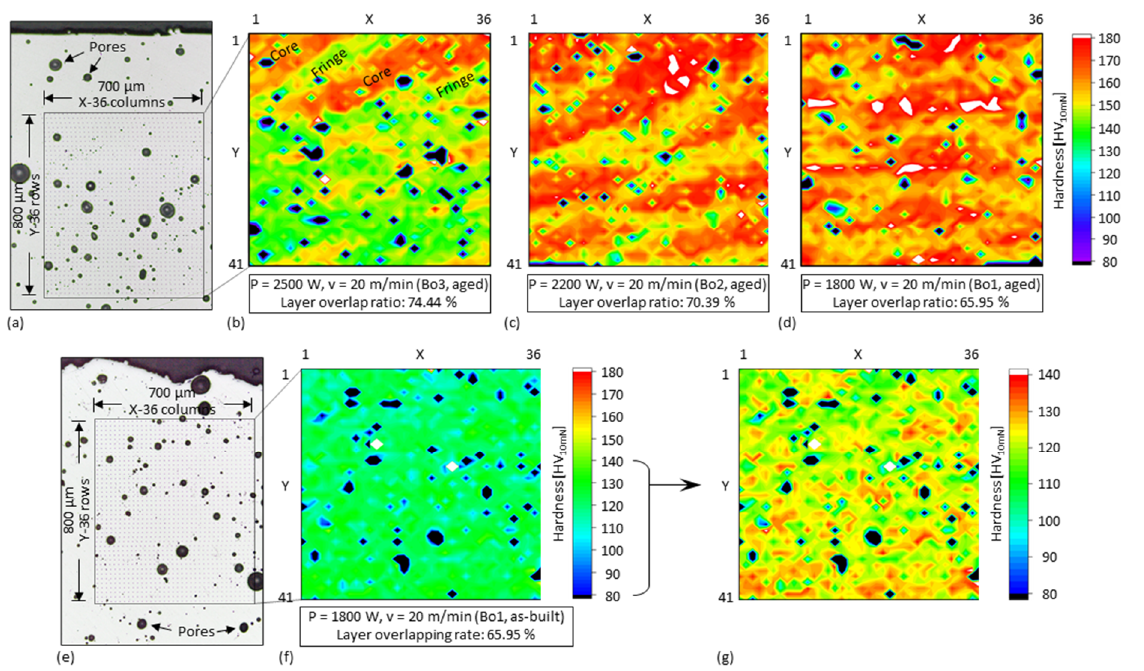
Figure 16. Microscopic images of the cross-section of the top layers of the specimen ( a ) Bo3 and ( e ) Bo1. Color-coded contour maps of the hardness distribution of aged (325 °C for 4 h) ( b ) Bo3, ( c ) Bo2, and ( d ) Bo1 and of ( f , g ) as-built Bo1. The ( b – d ) and ( f ) have the same color scale, which is partially enlarged in ( g ).